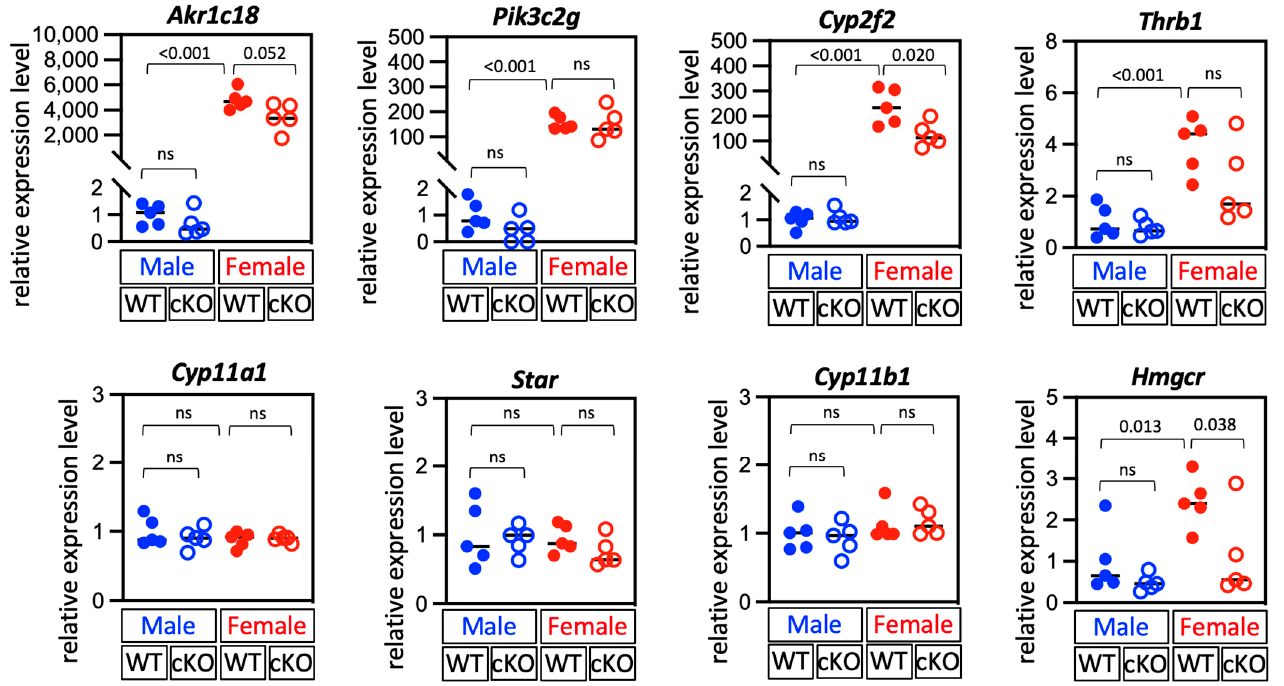
Figure 5. Quantitative polymerase chain reaction showed the relative expressions of key marker genes in the adrenal cortex. The relative expression levels of each gene in cKO mice were normalized to those of the male WT mice. Each dot (WT) and circle (cKO) represents data from one mouse. Data are shown with the mean. WT: wild-type mice, cKO: Dhcr24 conditional knockout mice. ns, no significant difference.